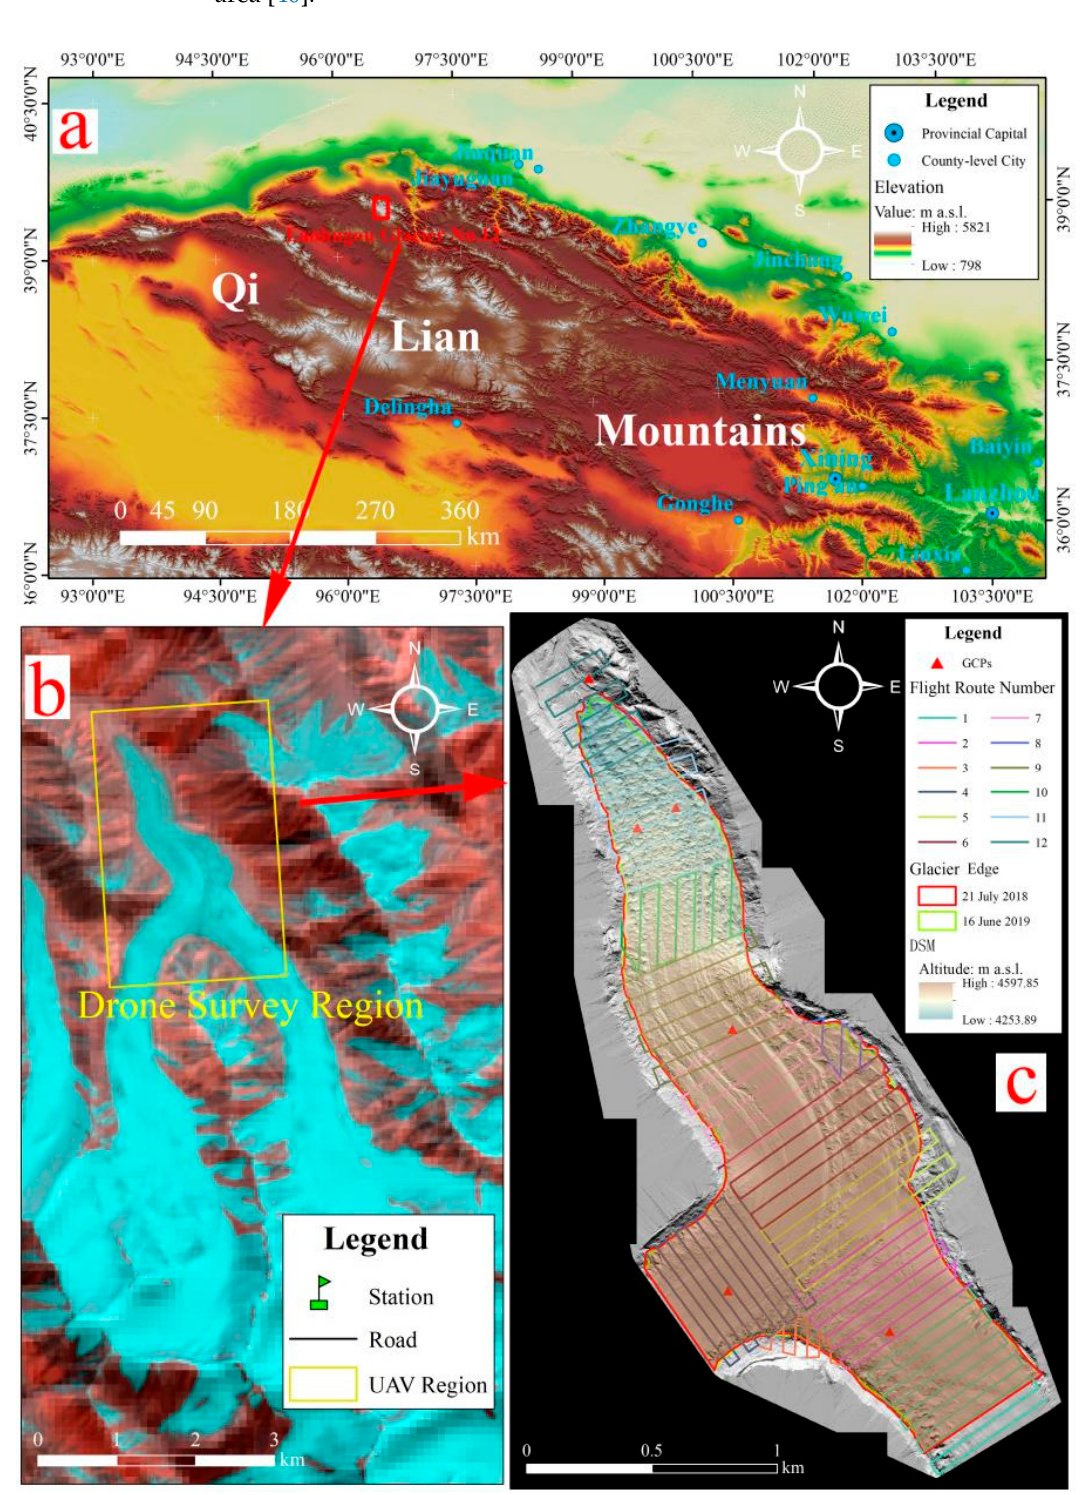
Figure 1. Study area. ( a ) Location of LHG12; ( b ) Drone survey region; ( c ) Drone-based image-capture routes and distribution of GCPs.